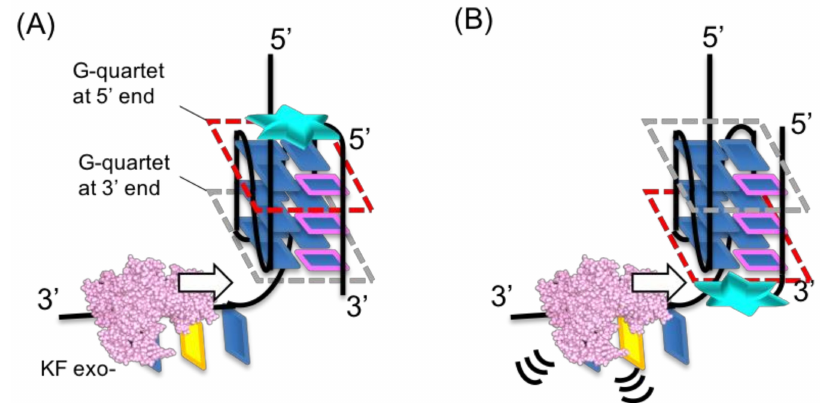
Figure 8. Regulation of G4 replication by a guanine tract conjugated at its ( A ) 5 (cid:48) end and ( B ) 3 (cid:48) end. The boxes highlighted in red indicate the affected G-quartet with the ligand moiety to decrease the unfolding